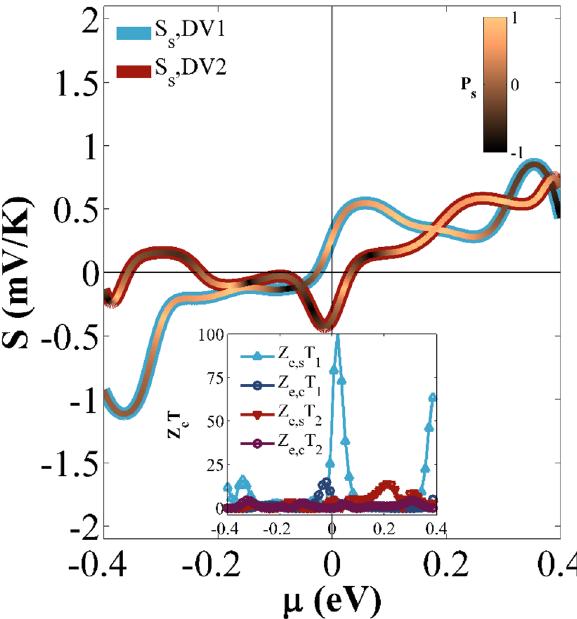
Figure 9. S up , S dn , S s , and S c against µ at room temperature for DV1and DV2 cases, respectively. S S color varies based on Seebeck polarization ( P s ) value. The inset shows Z e, s T and Z e, c T as a function of µ